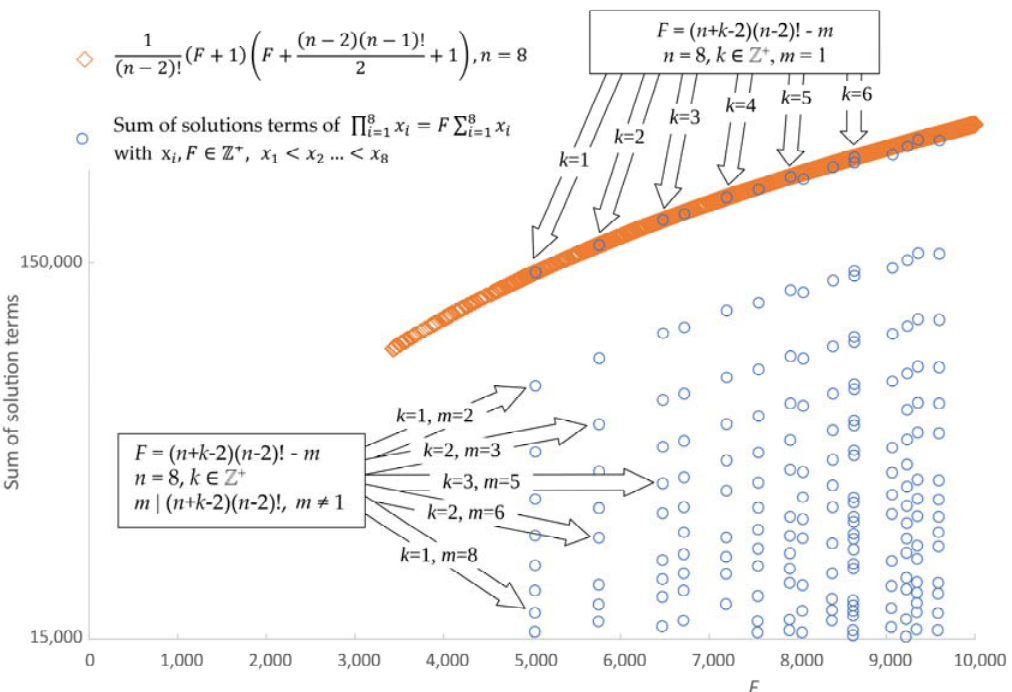
Figure 6. Sums of solution terms of Diophantine equation ∏ 𝑥 (cid:3036)(cid:2876) (cid:3036)(cid:2880)(cid:2869) = 𝐹 ∑ 𝑥 (cid:3036)(cid:2876) (cid:3036)(cid:2880)(cid:2869) with 𝑥 (cid:3036) ,𝐹 ∈ ℤ (cid:2878) for distinct-term solutions plotted together with a conjectured upper bound. A conjectured formula for parameter F such that the upper bound equals the largest sum of solution terms is shown in the upper part. A conjectured formula for F such that the largest sum of terms of distinct-term solutions is lower than the conjectured upper bound is shown in the left bottom part. The vertical axis was trimmed and log-scaled to improve the separation of adjacent data points.